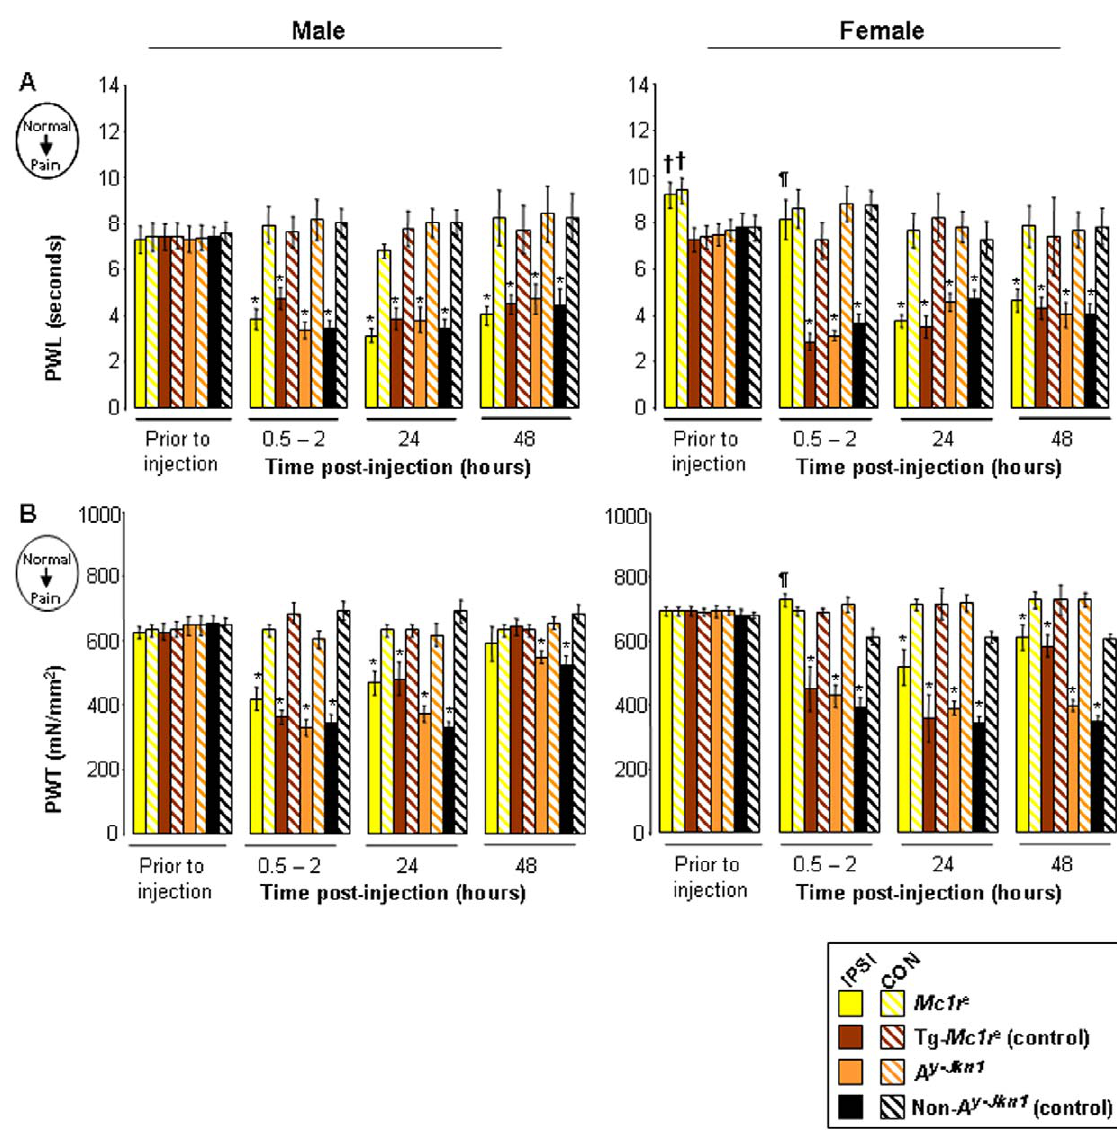
Figure 3. Effect of MC1R functionality on CFA-induced thermal hyperalgesia and mechanical allodynia. Data represents the paw withdrawal latency [ A ], paw withdrawal threshold [ B ] as measures of thermal hyperalgesia and mechanical allodynia prior to and post-injection of CFA (n=4–5 per genotype), shown as mean responses 6 SEM. Differences in behaviours prior to injection were observed in female Mc1r e mice only, when compared to their control littermates, Tg- Mc1r e in [ A ] paw withdrawal latency ( {{ P , 0.01). CFA-induced increased ipsilateral sensitivity (IPSI; injured hindlimb) compared to contralateral (CON; un-injured hindlimb) are shown (*P , 0.05). Female Mc1r e mice were found to have a significantly higher ipsilateral thresholds when compared to their control littermates, Tg- Mc1r e ipsilateral thresholds in [ A ] paw withdrawal latency and [ B ] paw withdrawal threshold at 0.5–2 hours post-injection ( " P , 0.05).